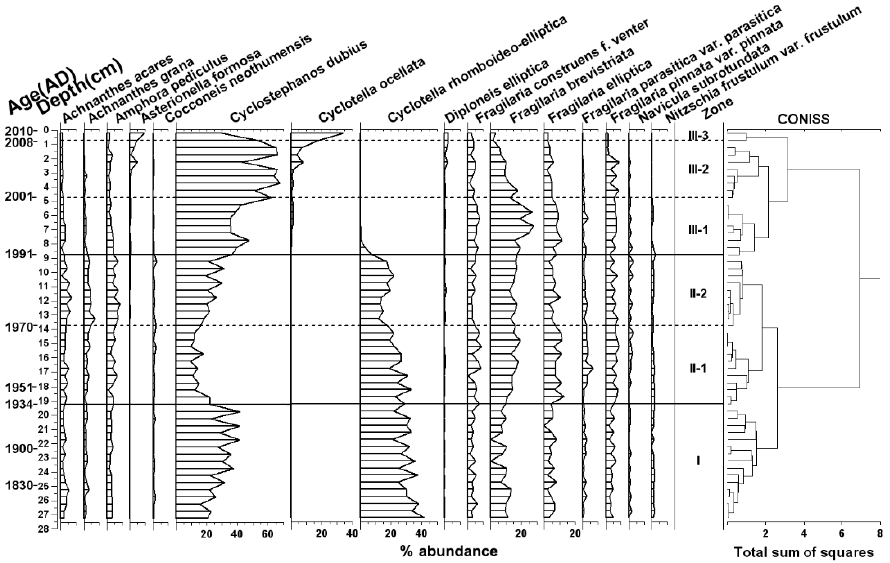
Figure A1. Historical trends of atmospheric HMs emissions (Tian et al., 2015).